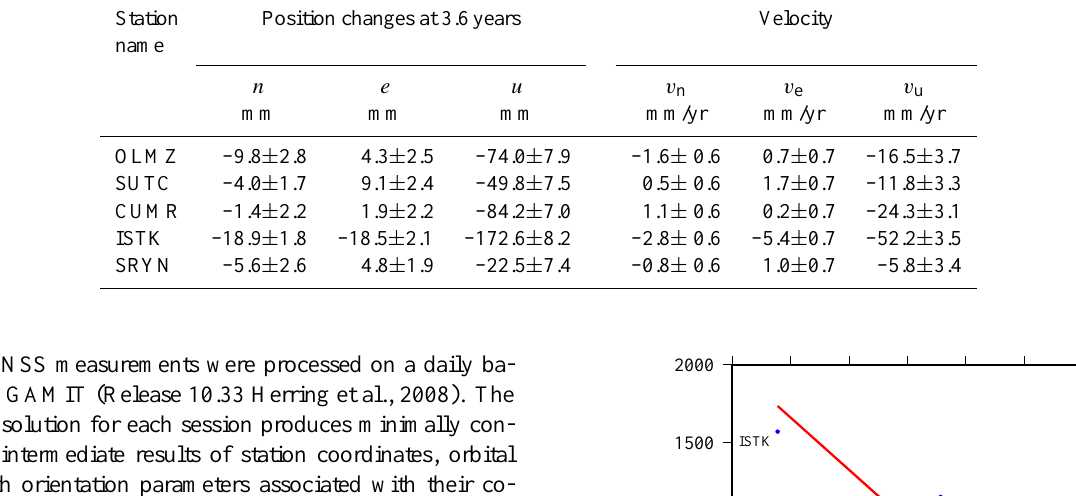
Table 2. Position changes and velocities and their uncertainties at GNSS stations (referred to KONY). Station